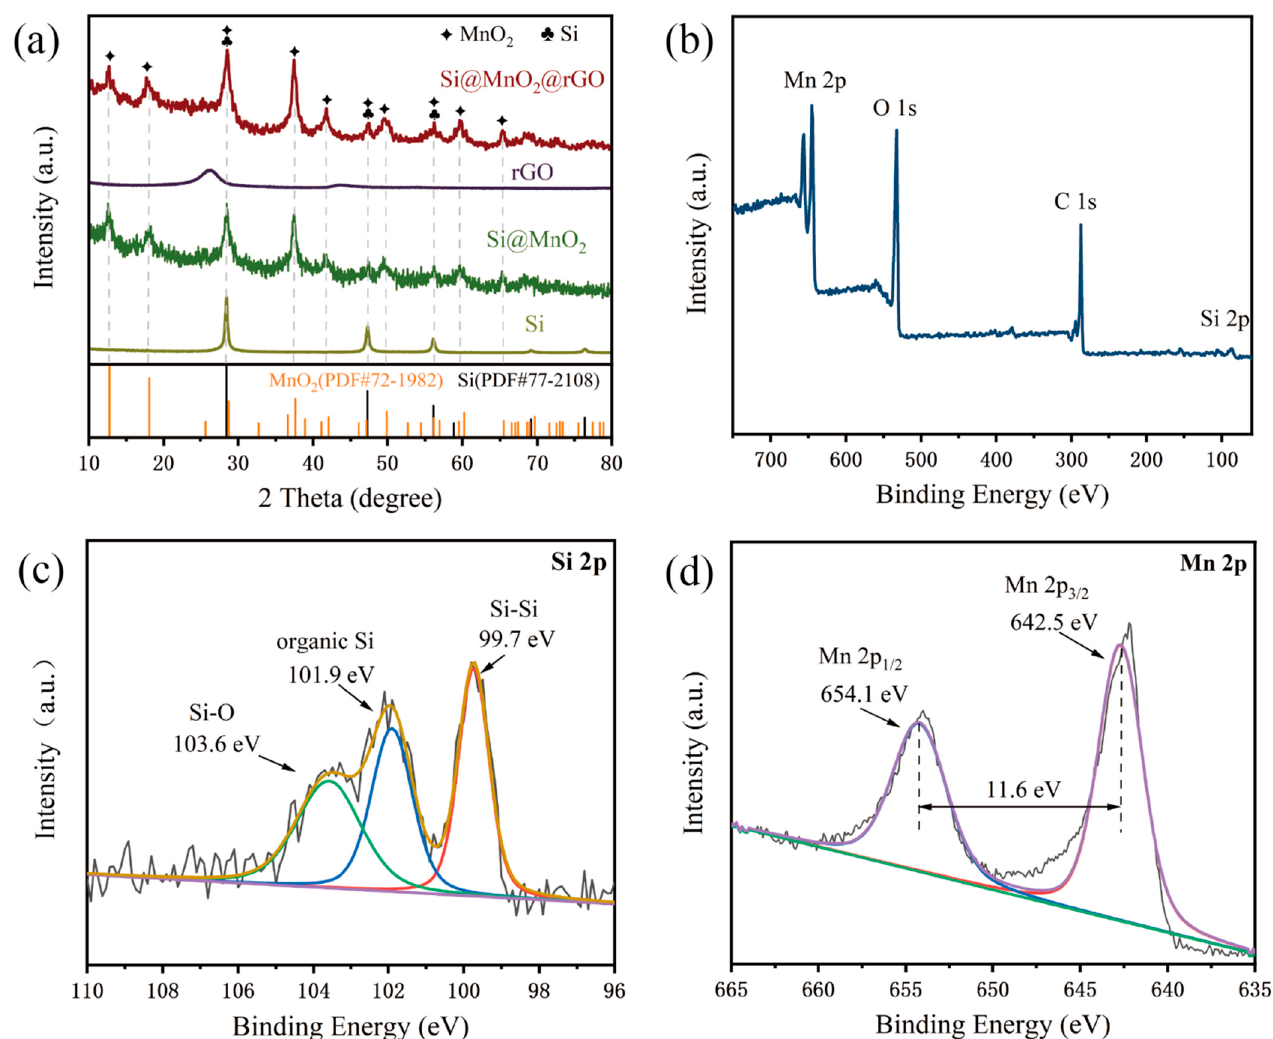
Figure 4. ( a ) X-ray diffraction (XRD) patterns of the Si, Si@MnO 2 -50°C rGO, and Si@MnO 2 @rGO- 50°C, respectively. ( b – d ) XPS spectra of the Si@MnO 2 @rGO-50°C .